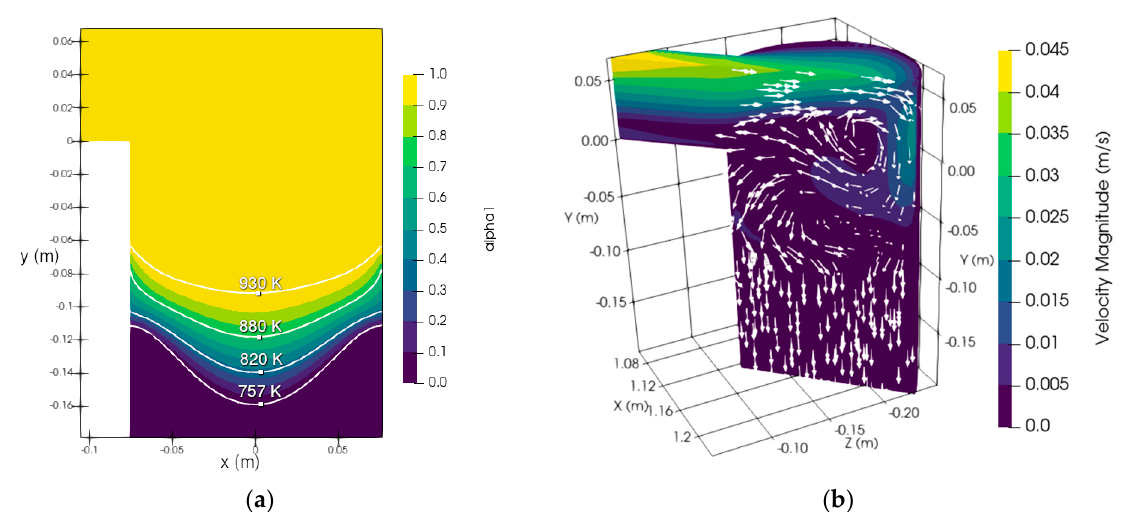
Figure 6. Resulting solid fraction and temperature profile (a), and fluid flow velocity magnitude (b) in the billet when applying UST in the launder.